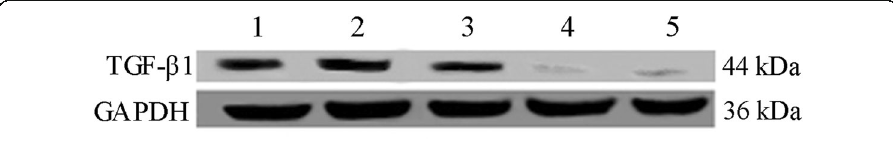
Fig. 2 Relative expression levels of TGF- β 1 protein. (1) Untreated group. (2) Negative control group. (3) pBOBI-gRNA1 infected group. (4) pBOBI-gRNA2 infected group. (5) pBOBI-gRNA3 infected